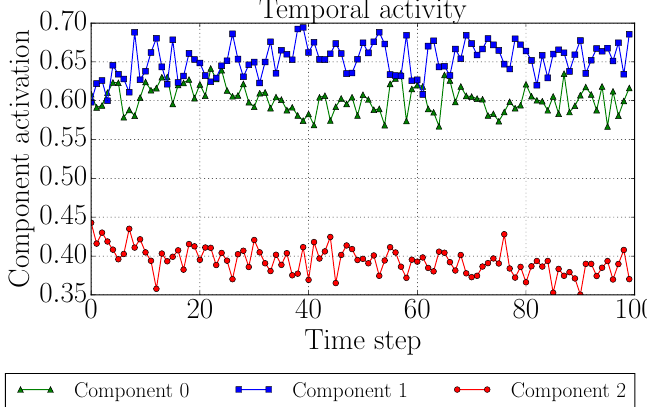
Figure 6. Temporal activity of each component. The values displayed coincide to those in the columns of C . The different markers characterize the different components, according to the clusters colouring.